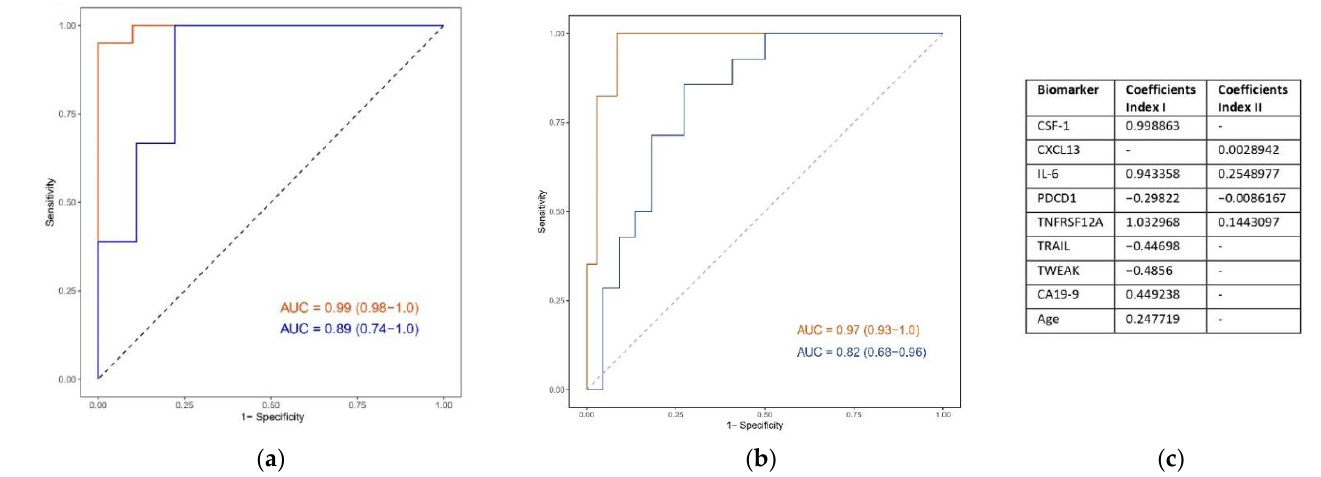
Figure 1. Prognostic signature, Receiver Operating Characteristics (ROC) curves. The orange lines indicate performance in the discovery cohorts, and the blue lines indicate performance in the repli- cation cohorts: ( a ) ROC plots Index I (CSF-1, IL-6, PDCD1, TNFRSF12A); ( b ) ROC plots Index II (CXCL13, IL-6, PDCD1, TNFRSF12A); ( c ) coefficients for the biomarkers included in Index I and Index II. The three proteins overlapping between the two indices are marked in red.